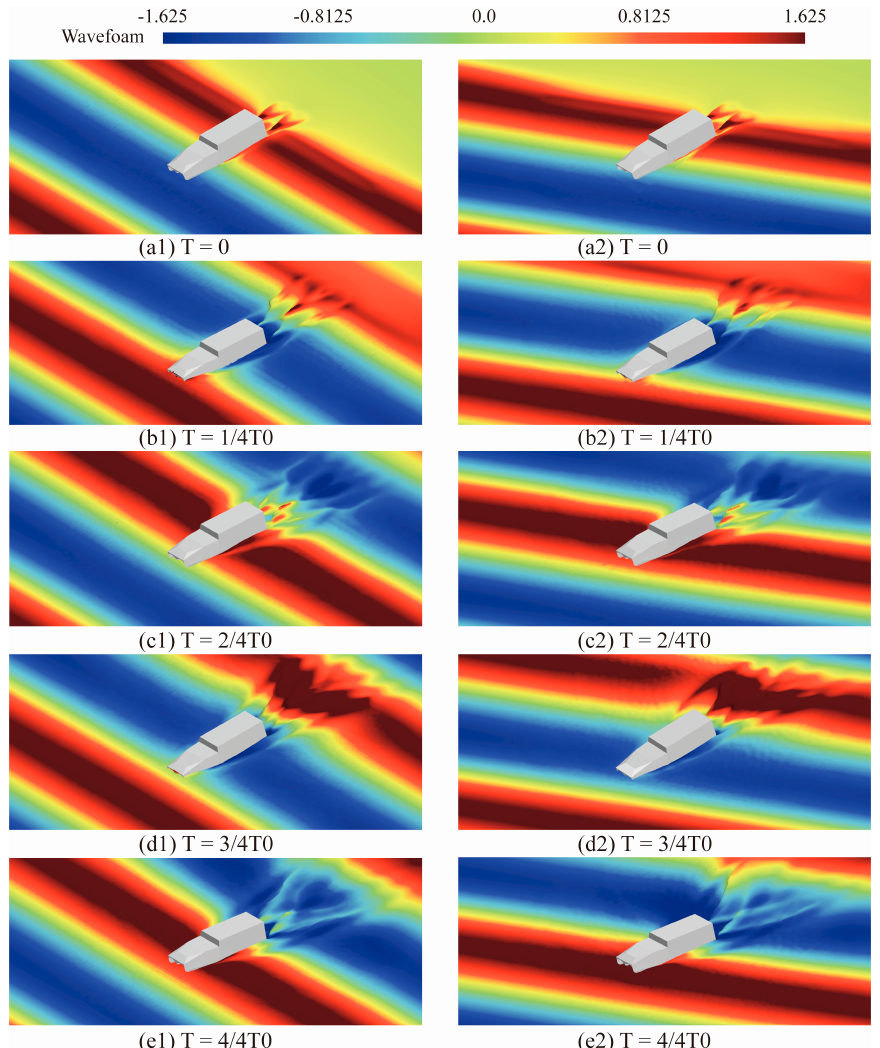
Figure 27. Free surface waveform and USV three-dimensional attitude at 7 level sea state (( left ): 0° wave direction; ( right ): 30° wave direction).